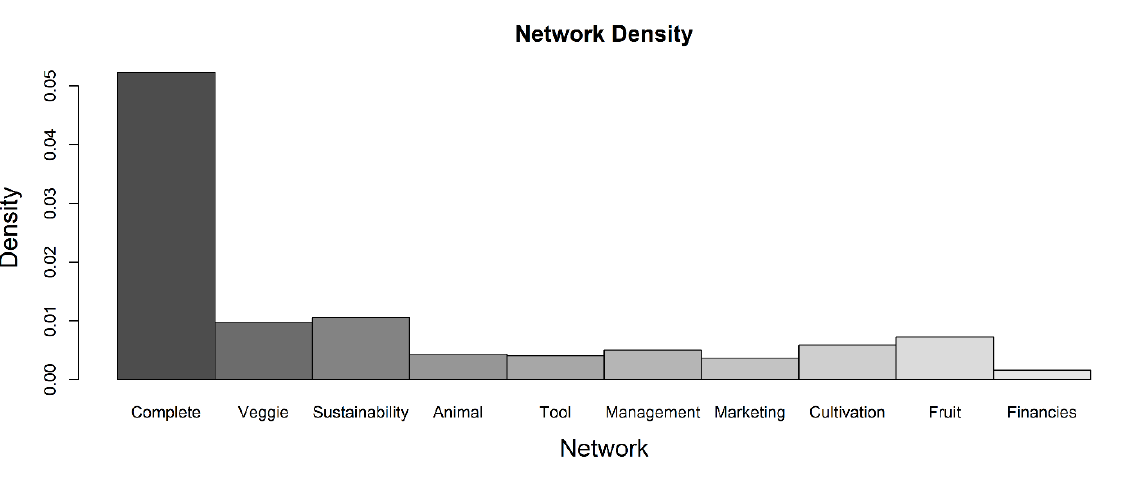
The sub-networks based on production types and information requests were significantly less integrated than the overall network, with approximately 0.5 percent of links present on average (see Figure 5).